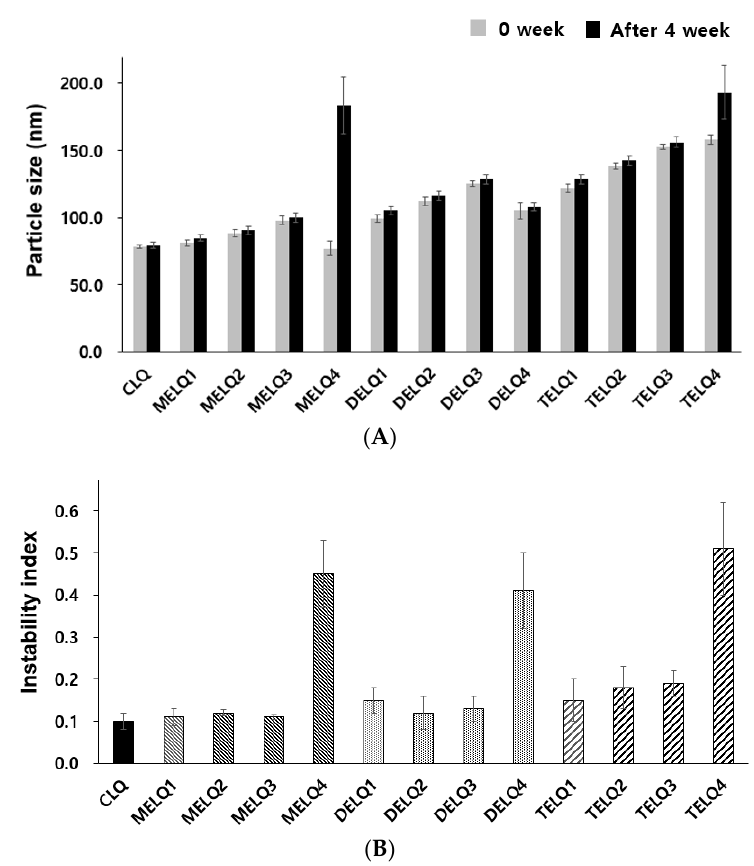
Figure 1. Stability of nanoliposomes. ( A ) Particle size for nanoliposomes after 0 week and 4 weeks. ( B ) Instability index.